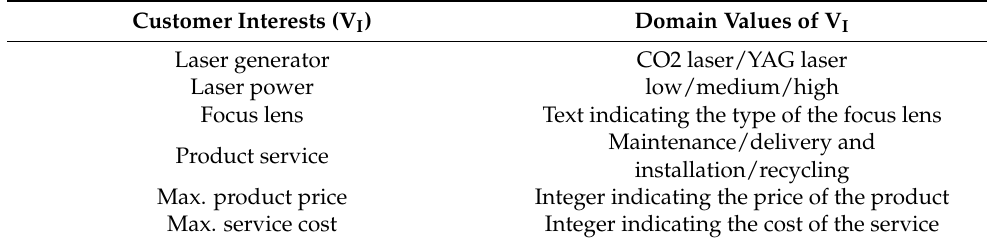
Table 3. Examples of customer requirement variables.